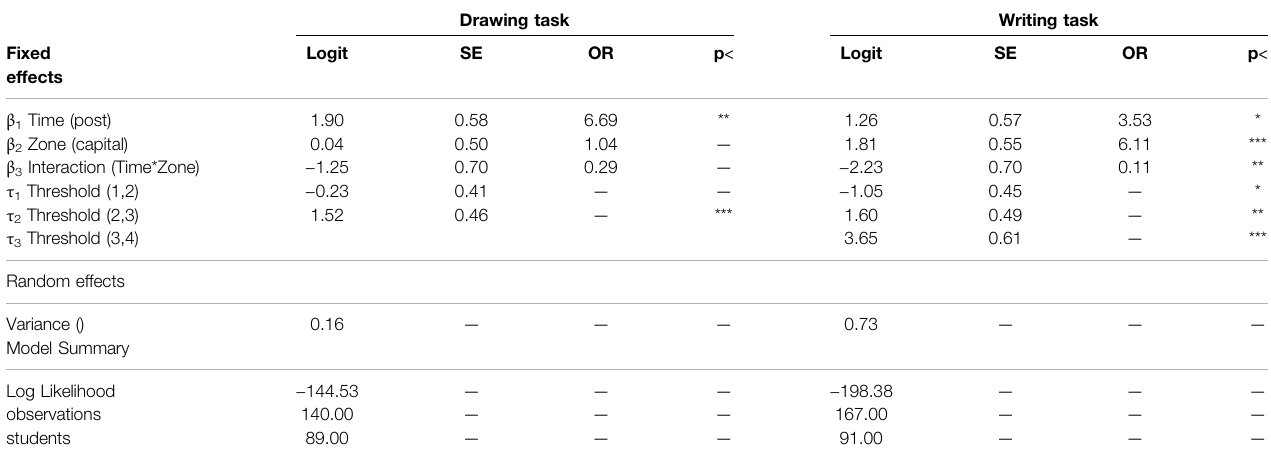
TABLE 3 | Mixed ordinal logit estimates to compare scores before and after a learning